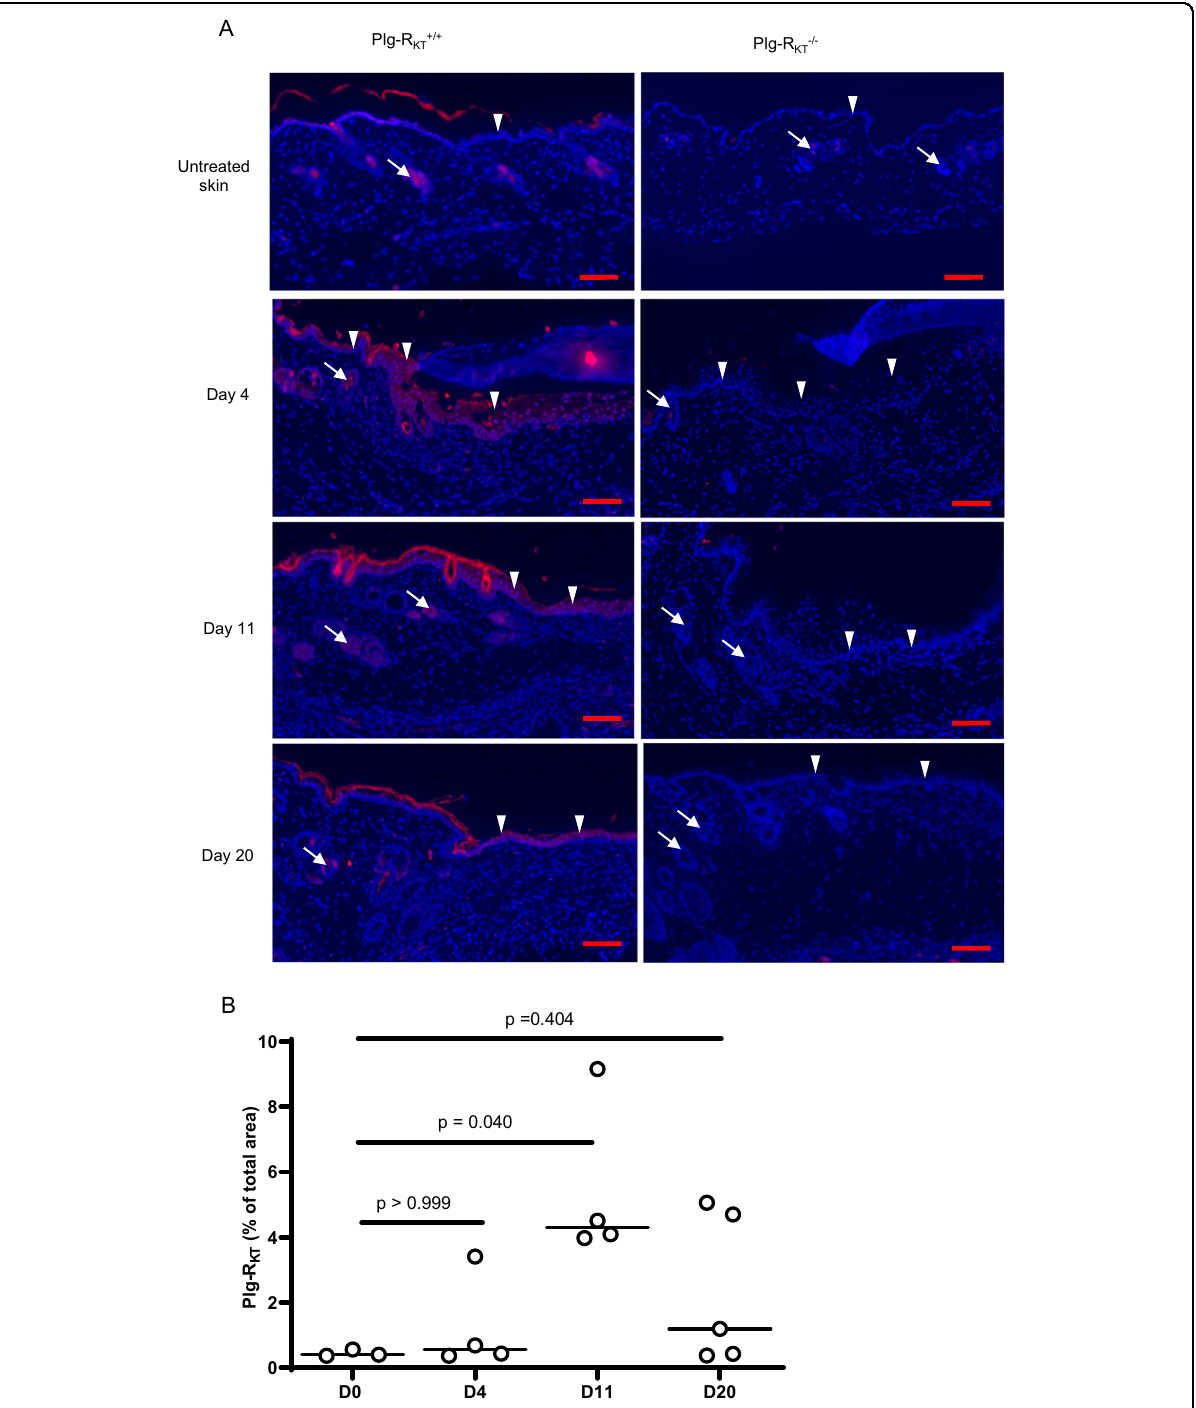
Fig. 3 Expression of Plg-R KT in wound tissue. A Paraf fi n sections of wound tissue from Plg-R KT − / − and Plg-R KT + / + littermates were immunostained with anti-Plg-R KT mAB (red) and DAPI (blue). Scale bar = 200 µm. White arrows indicate hair follicles, white arrowheads show keratinocytes. B Quantitation of the Plg-R KT staining in Plg-R KT + / + (shown as % of total wound area). By Krustal – Wallis test, p = 0.054, Krustal – Wallis statistic = 7.1 followed by Dunns Multiple Comparisons, Day 0 vs. Day 4, p ≥ 0.999, Day 0 vs. Day 11 p = 0.040 and Day 0 vs. Day 20, p = 0.404, ( n = 4). Medians are displayed. Images were captured with a Zeiss Axio Imager Z1 (Zeiss, Oberkochen, Germany) or Nikon A1R Eclipse Ti-E inverted microscope (Nikon Instruments, Amsterdam, Netherlands). Quanti fi cation of fl uorescent areas was performed using Image J